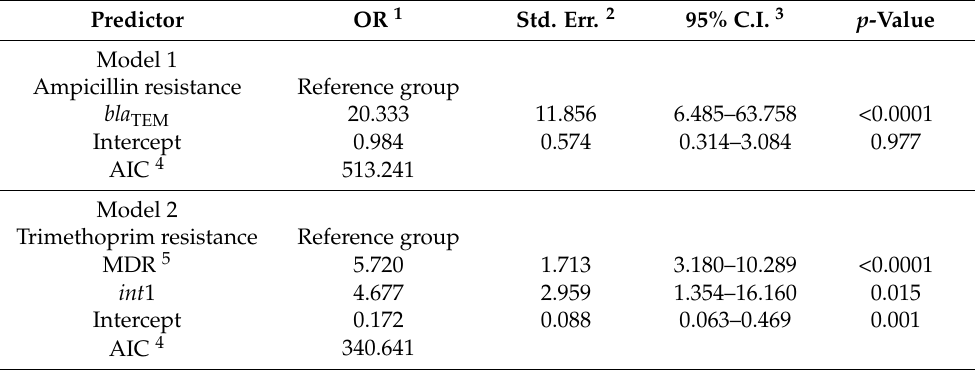
Table 5. Multivariate logistic regression analysis of factors associated with ampicillin resistance